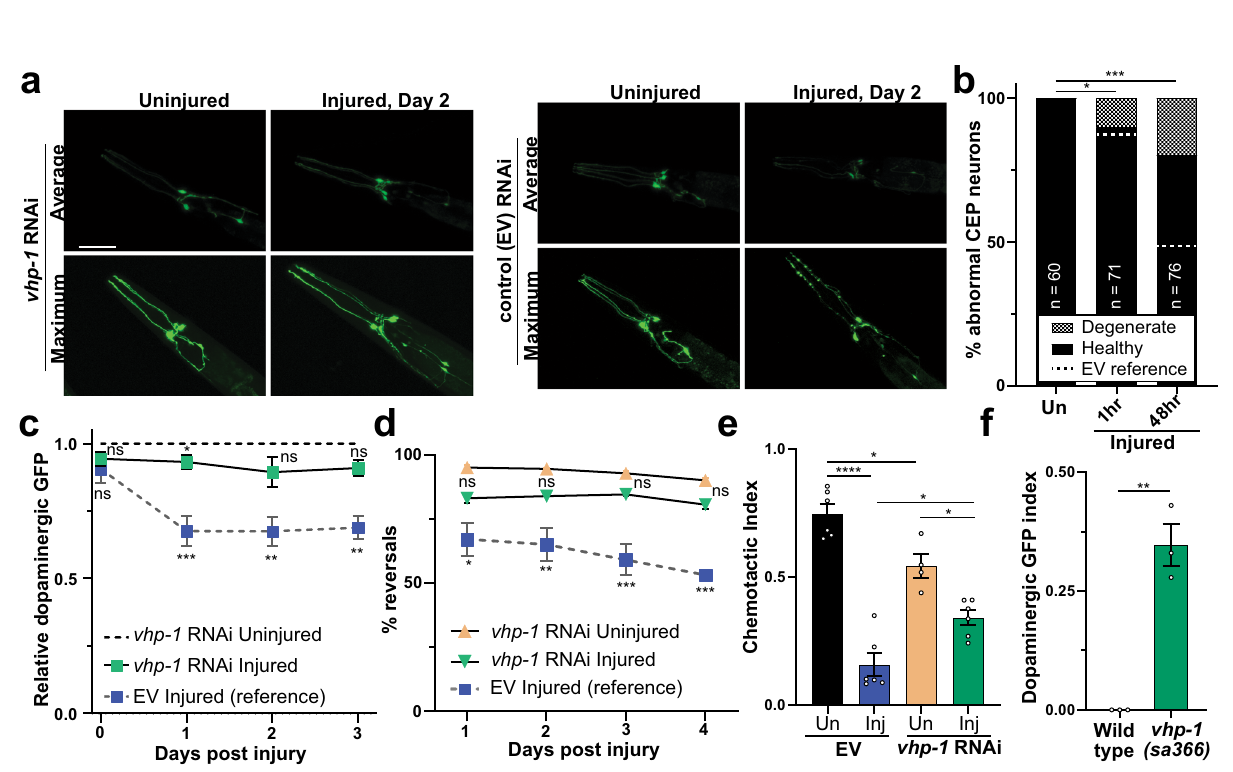
Fig. 5 Reducing VHP-1 expression suppresses trauma-induced neurodegeneration. a Confocal micrographs of GFP expressing dopaminergic neurons with and without injury and vhp-1 RNAi. Shown are average or maximum projections of Z-stacks. Reference Fig. 5b, c. Scale = 50 µ m. b Quanti fi cation of CEP neuronal phenotype from vhp-1 RNAi maximum projections. vhp-1 RNAi uninjured (Un) versus injured * p = 0.0124, *** p = 0.0003. vhp-1 RNAi versus empty vector (EV, dashed lines) 1 and 48 hour (h) post injury, ns (not signi fi cant) p = 0.8122, and **** p < 0.0001 respectively, chi-squared test. c Large- particle fl ow cytometry time-course comparing effects of dopaminergic GFP retention in injured vhp-1 RNAi (green squares) to uninjured vhp-1 RNAi (---). Injured empty vector (EV, blue squares) reference from Fig. 3D, gray dashed lines. Mean± 95% CI. Mixed-effects analysis with Tukey ’ s multiple comparisons test. See Supplementary Data 5 for statistics. d Nose-touch response of uninjured (tan upright triangles) or injured (green inverted triangles) worms on vhp-1 RNAi. Injured empty vector (EV, blue squares) reference from Fig. 1J (gray dashed lines) Mean ± SEM. See Supplementary Data 5 for statistics. e Chemotaxis of uninjured (Un, black and tan) or injured (Inj, blue and green) worms on empty vector (EV, black and blue) or vhp-1 RNAi (tan and green) with butanol 48 h post injury. Chemotactic index of 1.0 indicates 100% preference for butanol and 0.0 indicates no preference. Mean ± SEM, biological replicates denoted. See Supplementary Data 5 for statistics. f Large-particle fl ow cytometry results of wild type, PMD13, and vhp-1(sa366) mutants, PMD153, in green two days post trauma. Dopaminergic GFP index indicates relative loss of dat-1p::GFP signal in injured vhp-1(sa366) mutants (green) compared to injured wild type. Mean ± 95% CI. ** p < 0.0015, two-sided paired t -test, n = 1902 for wild type and n = 1342 for vhp-1(sa366) over three independent trials. Positive values indicate reduced loss of fl uorescence when compared to age-matched uninjured controls. A value of one indicates no change of fl uorescence compared to uninjured fold, FDR p ≤ 0.05) were also upregulated upon vhp-1 knockdown cadmium stress-response, innate immunity, metal ion binding, (Fig. 4h), suggesting an important regulatory role for VHP-1 in neuronal signaling, and locomotion (Supplementary Fig. 4a – c). the transcriptional response to mechanical stress or pre- conditioning of animals to better sustain trauma. Enrichment analysis of these 460 shared transcripts revealed genes involved in dopaminergic neurons (Fig. 5a – c). Compared to the EV control,